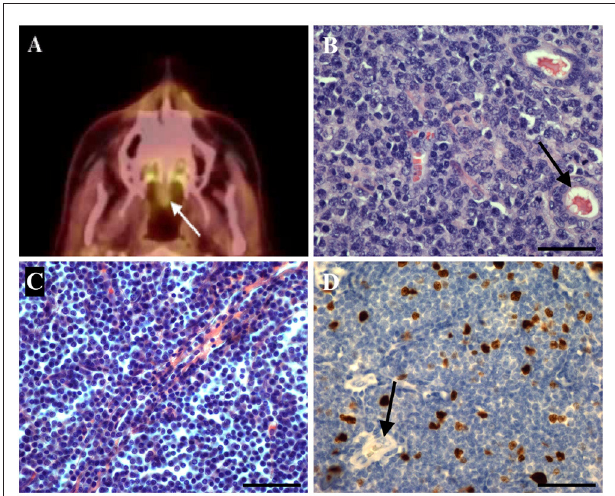
FIGURE 1 | (A) A 68-year-old male presented with a firm swelling of the uvula and was subsequently diagnosed with a peripheral T-cell lymphoma (PTCL). Positron emission tomography-computed tomography (PET-CT) showed increased fluorodeoxyglucose (FDG)-uptake in the uvula (white arrow). (B) Histological image of the uvular PTCL shown in (A) . The uvular tissue is infiltrated by large tumor cells with irregular and vesicular nuclei. Black arrow: duct from a palatine gland (HE). (C) A 68-year-old male presented with swelling of the uvula and B-symptoms, including prolonged fever, night sweats, fatigue and weight loss, and was subsequently diagnosed with an extranodal marginal zone B-cell lymphoma (EMZL). The tumor tissue is characterized by small tumor cells with slightly irregular nuclei and moderately dispersed chromatin (HE). (D) Immunohistochemistry of the EMZL shown in (C) . Staining of the proliferation marker Ki-67 in the cells’ nuclei shows a proliferation index of 5%. Black arrow: duct from a palatine gland. Scale bar = 50 µ